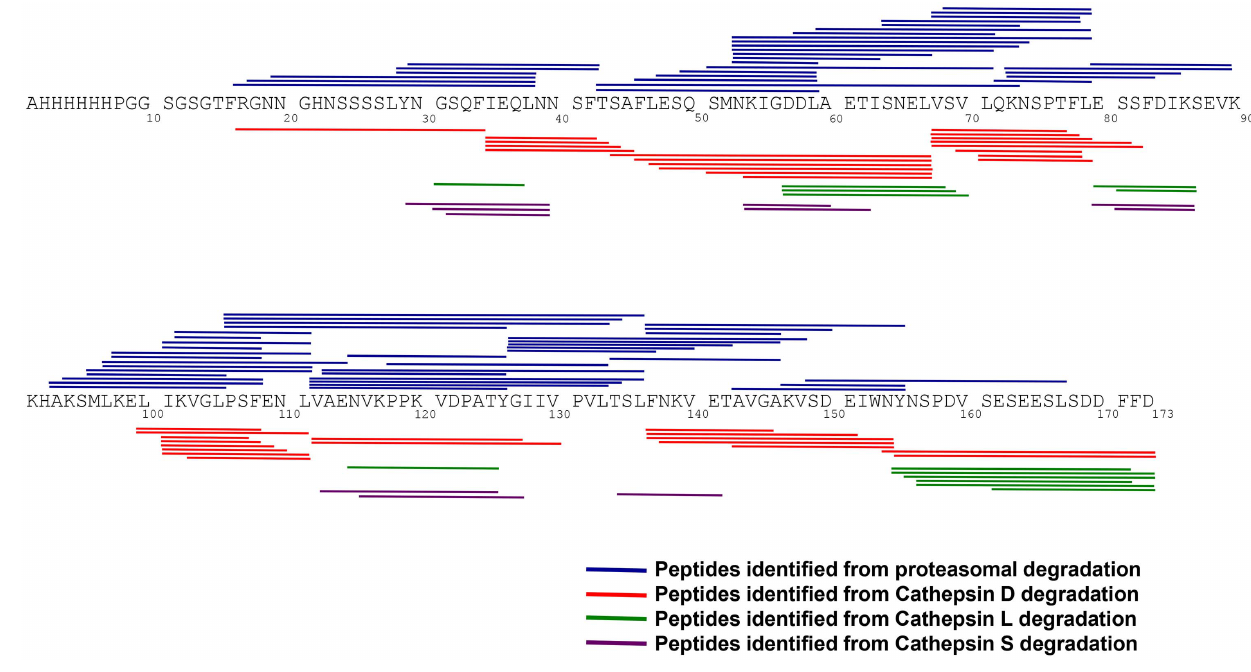
Figure 4. Proteasomal and Cathepsin cleavage maps of CelTOS. The proteasomal and Cathepsin D, L and S peptide fragments were separated by UFLC, analyzed on an LCMS-IT-TOF mass spectrometer and then identified using the MASCOT data base. The peptides derived from the proteasomal degradation of CelTOS (blue lines) are denoted above the sequence, and Cathepsin D (red lines), Cathepsin L (green lines) and Cathepsin S (purple lines) are denoted below the sequence, represent the identified peptides. The data shown is representative of two separate experiments.